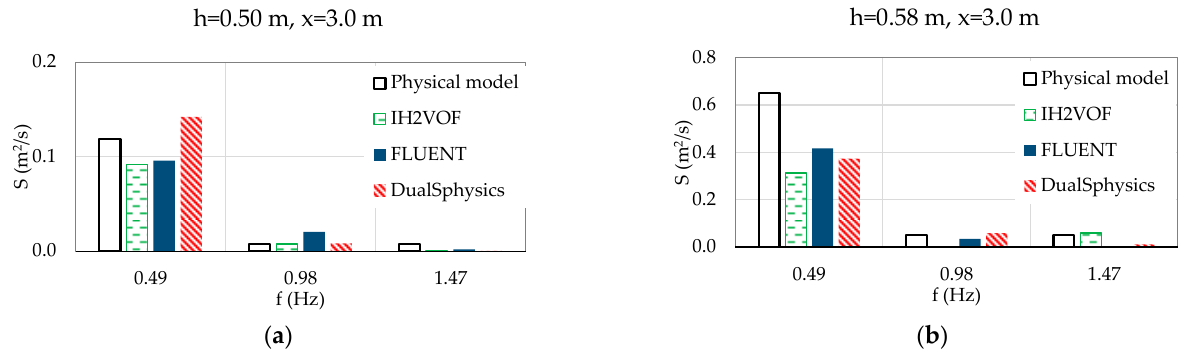
Figure 11. Values for the 1st, 2nd, and 3rd harmonics of the spectrum at x = 3.0 m for test 1 ( a ) and test 5 ( b ).